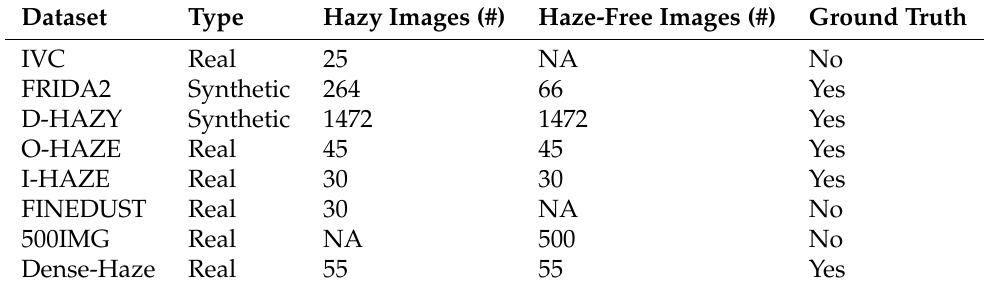
Table 1. Summary of real and synthetic datasets employed in this study. NA stands for not